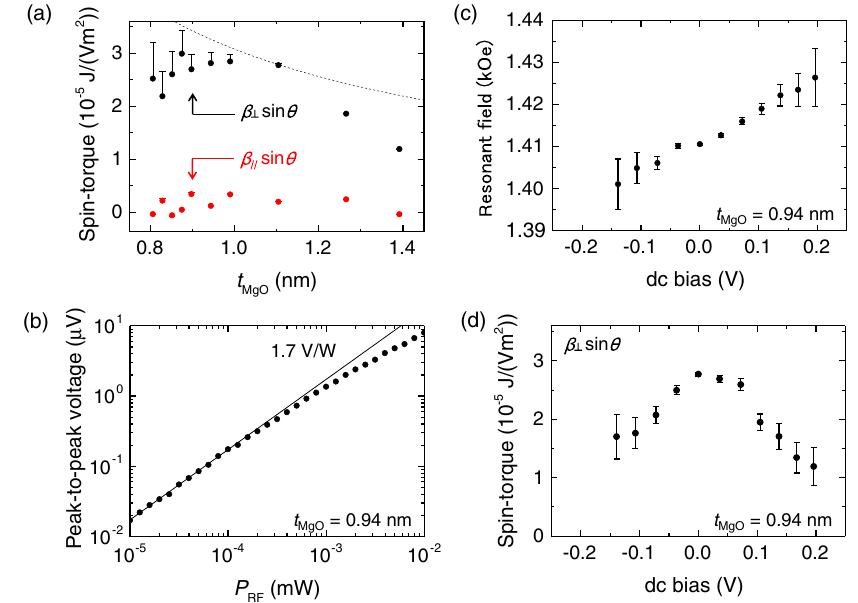
FIG. 4. (a) Torque vector components. Black and red circles represent perpendicular ( β ⊥ ) and in-plane ( β == ) torque, respectively. The dashed curve shows the theoretical line of the torque induced by the voltage-controlled magnetic anisotropy of 180 fJ = Vm. (b) Input power dependence of peak-to-peak dc voltage in the spin-torque FMR spectra. (c) The dc-bias-voltage dependence of the resonant field. (d) The dc-bias-voltage dependence of the perpendicular torque. All data were obtained with a magnetic-field angle of θ H ¼ 45 ° and an input microwave frequency of 5